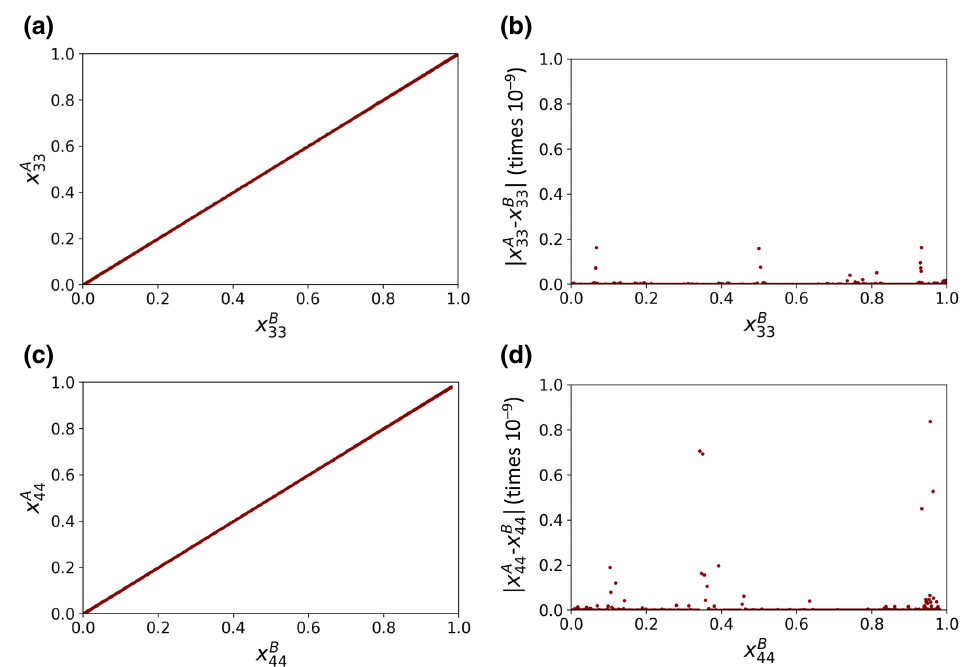
FIG. 3. Plots of (a) x B ver- 33 sus x A , and (c) x B versus 33 44 , where x A and x A are x A 44 33 44 predicted using the recon- structed density matrix. The linear plots in (a), (c) show = x B that x A for all values KK KK of x B K . Plots of the abso- K lute difference between (b) and the true the predicted x A 33 and (d) the mean value x B 33 and the true predicted x A 44 . Absolute dif- mean value x B 44 ferences of the order of 1 × 10 − 9 in (b), (d) show that the reconstructed density matrix correctly predicts the value of x KK